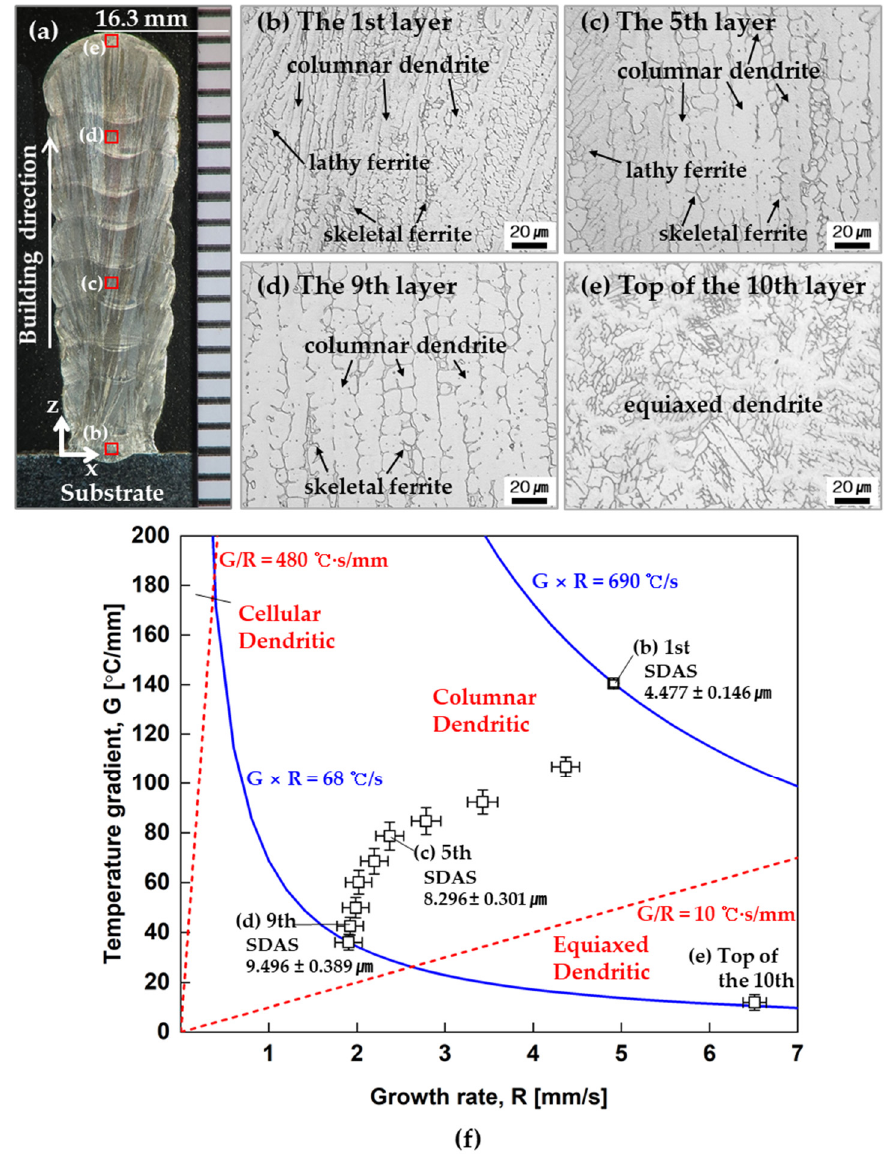
Figure 6. Solidification map of 316L SS for the CMT-WAAM process and optical microscopy images of the microstructure in the deposit manufactured by the CMT-WAAM process; ( a ) cross-section of deposit; ( b ) optical microscopy images of first layer; ( c ) fifth layer, ( d ) ninth layer, and ( e ) top of the tenth layer, ( f ) solidification map.